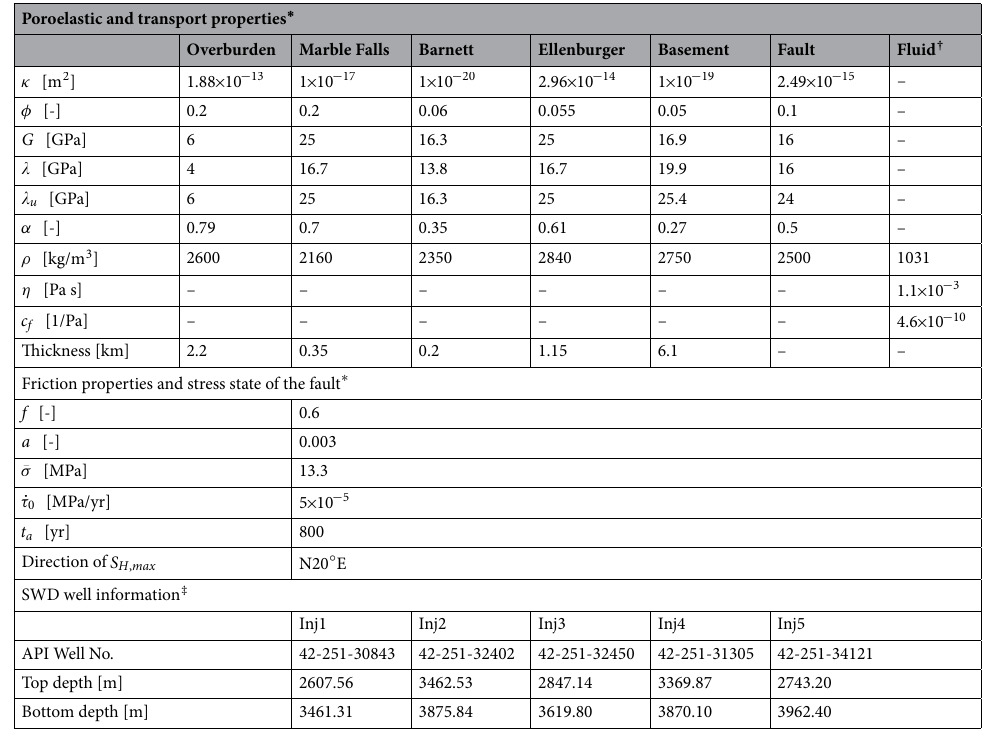
Poroelastic and transport ∗